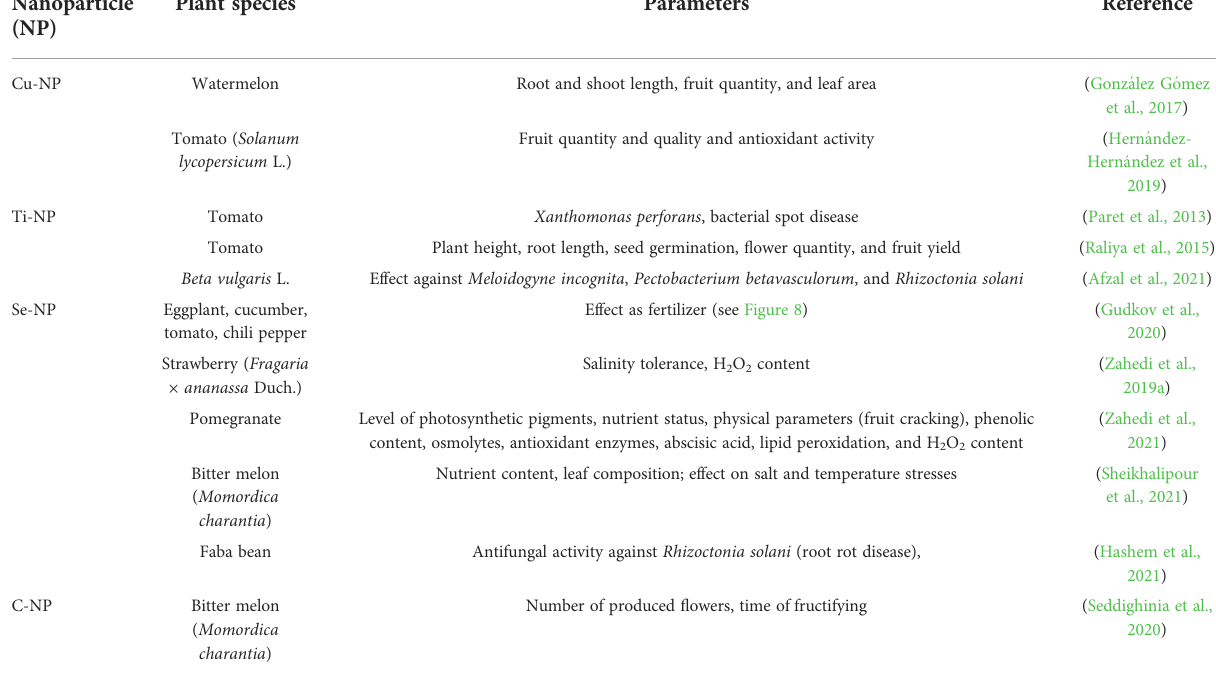
TABLE 5 Application of engineered nano-materials to enhance fruit yield and control disease in plants. Nanoparticle